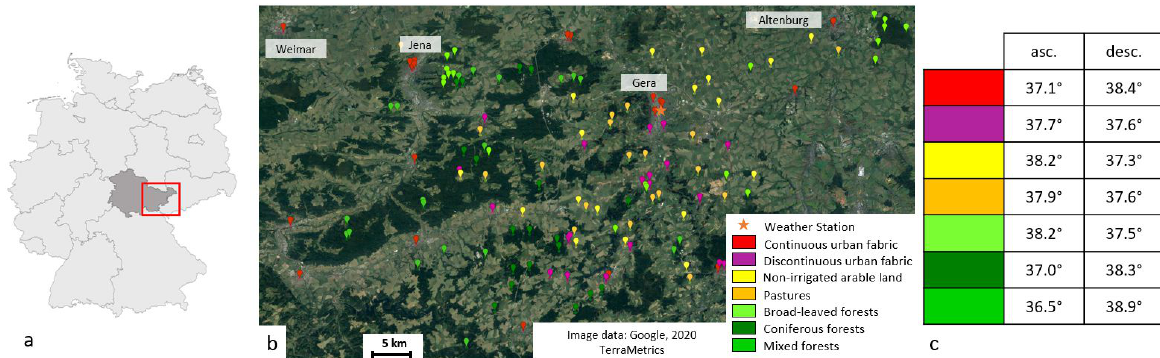
Figure 1: a) Overview of the geographical location of the study area in the Free State of Thuringia, Germany; b) reference points for each land cover class (color-coded); c) average incidence angle in ascending and descending direction, for each